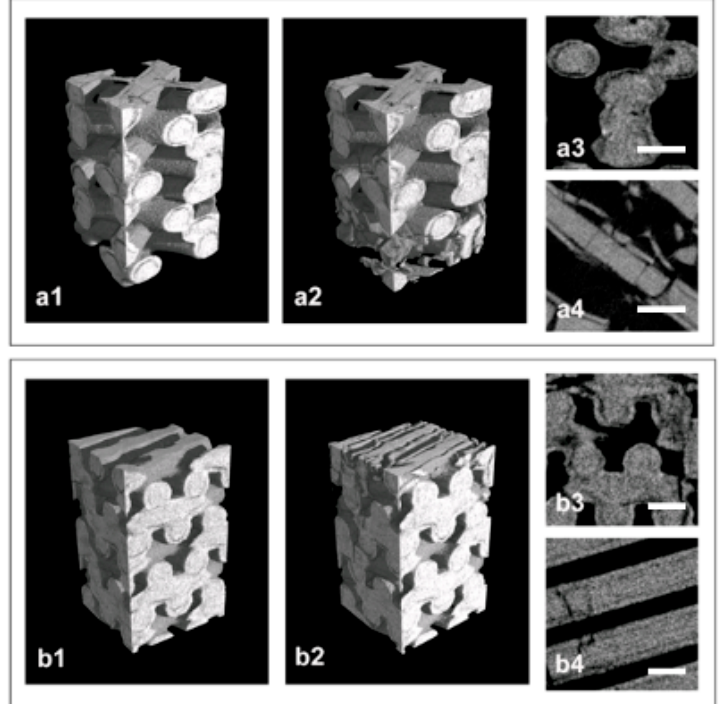
Figure 1. Microtomography (MicroCT) analysis of the laser light stereo ‐ lithography (SLA) ‐ 3D ‐